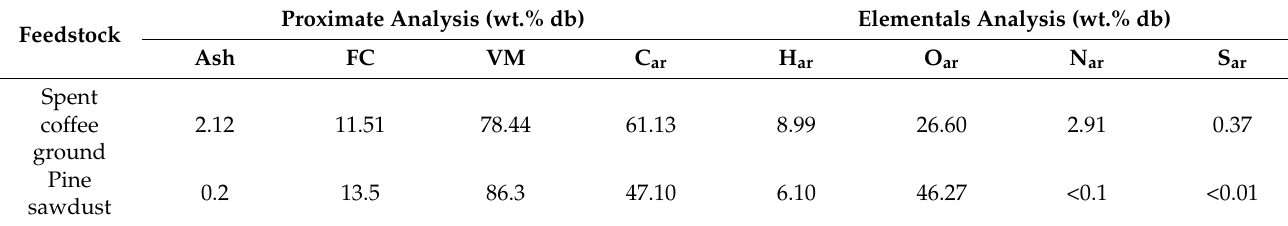
Table 1. Proximate and elementals analysis of feedstock. Proximate Analysis (wt.% db) Elementals Analysis (wt.% Feedstock